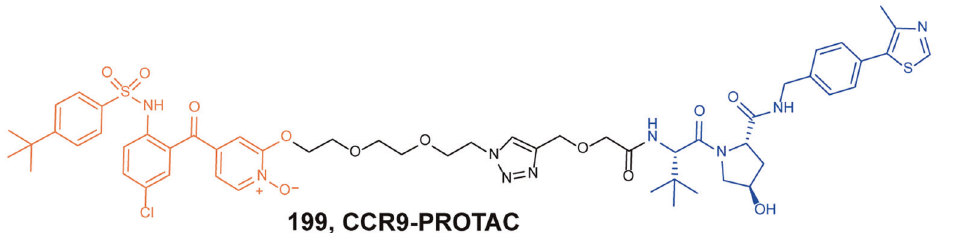
Fig. 54 The representative PROTAC targeting CCR9